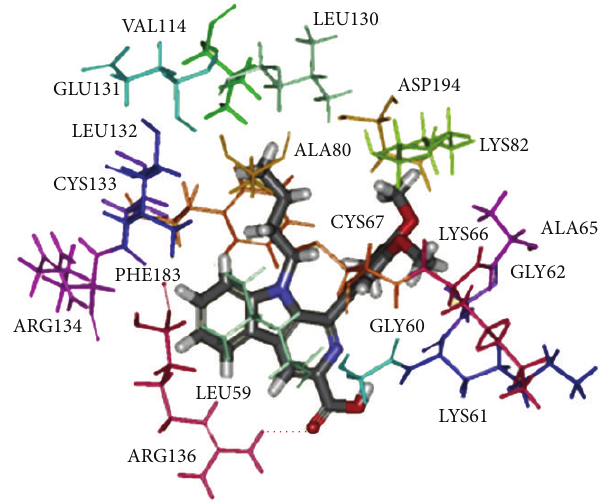
Figure 6: Molecular docking between compound 3 and PLK1, in which key residues of protein are shown as sticks. The dotted red line indicates hydrogen bonding